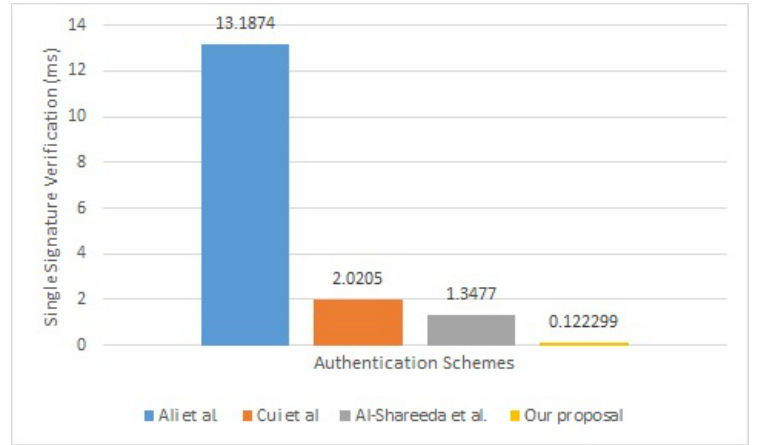
Figure 4. Computation cost of single signature verification for authentication schemes.